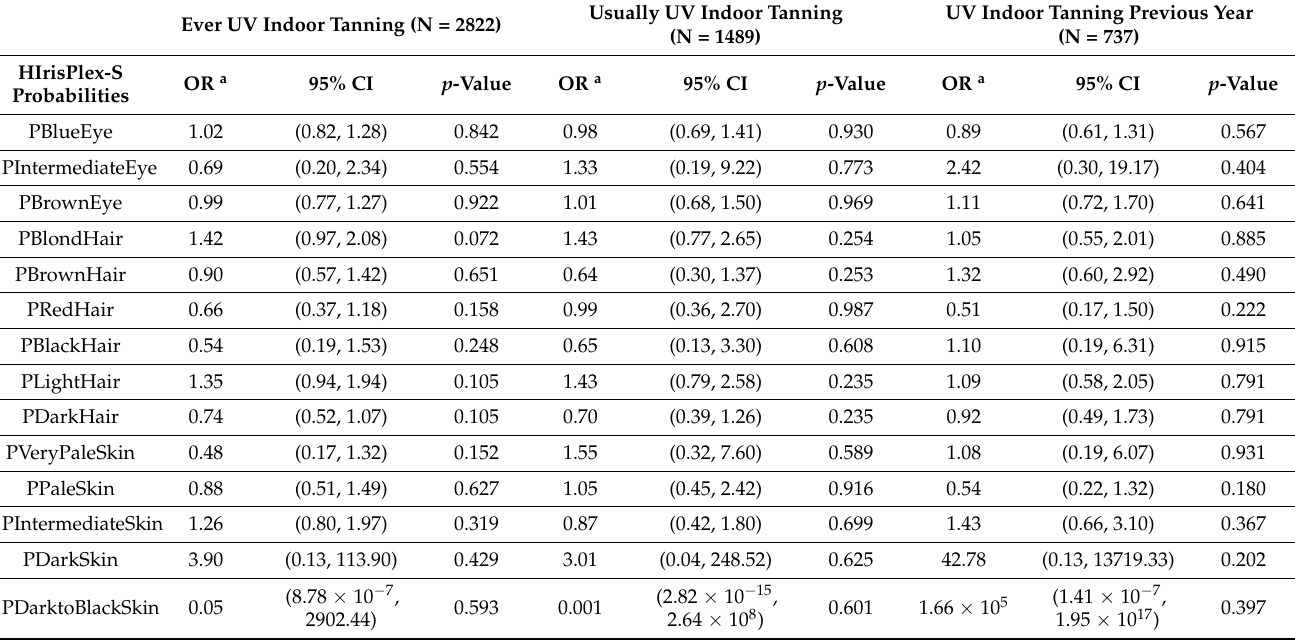
Table 5. Association of having ever used UV indoor tanning equipment, usually undergoing UV indoor tanning and UV indoor tanning in the last 12 months with HIrisPlex-S prediction probabilities of pigmentation traits in ALSPAC young people